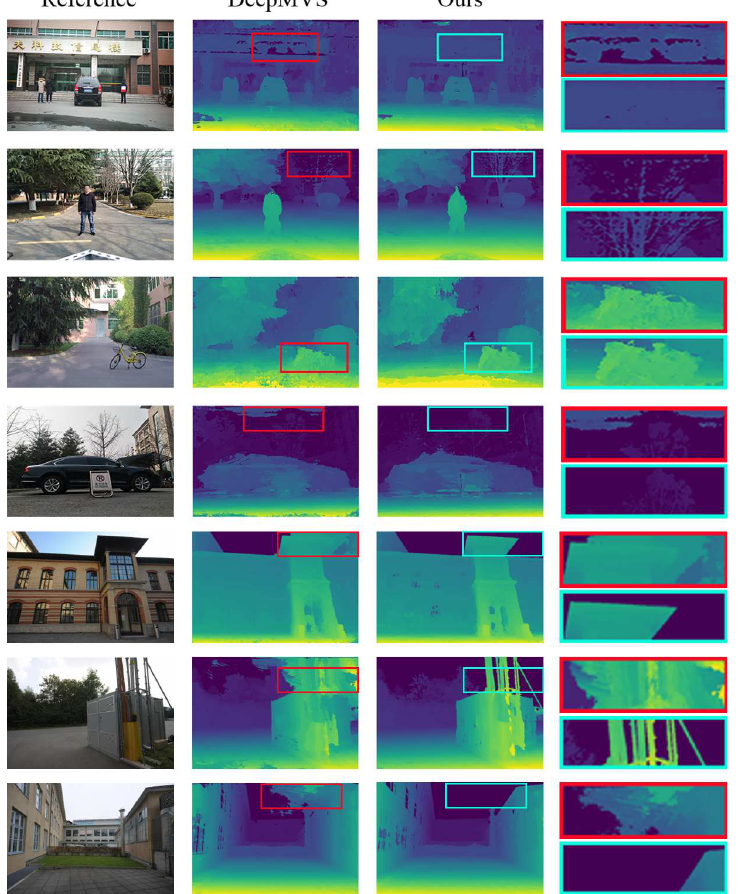
Figure 6. Qualitative comparison with DeepMVS. From the first, fourth, fifth and seventh rows, it can be seen that DeepMVS made many incorrect estimations on the wall and the sky, and the results of our method are visually better. The estimation for detailed structure is shown in the second row, the third row and the sixth row, where our method can accurately show the shapes of the branches, the bicycle and the metal rod, while DeepMVS cannot.